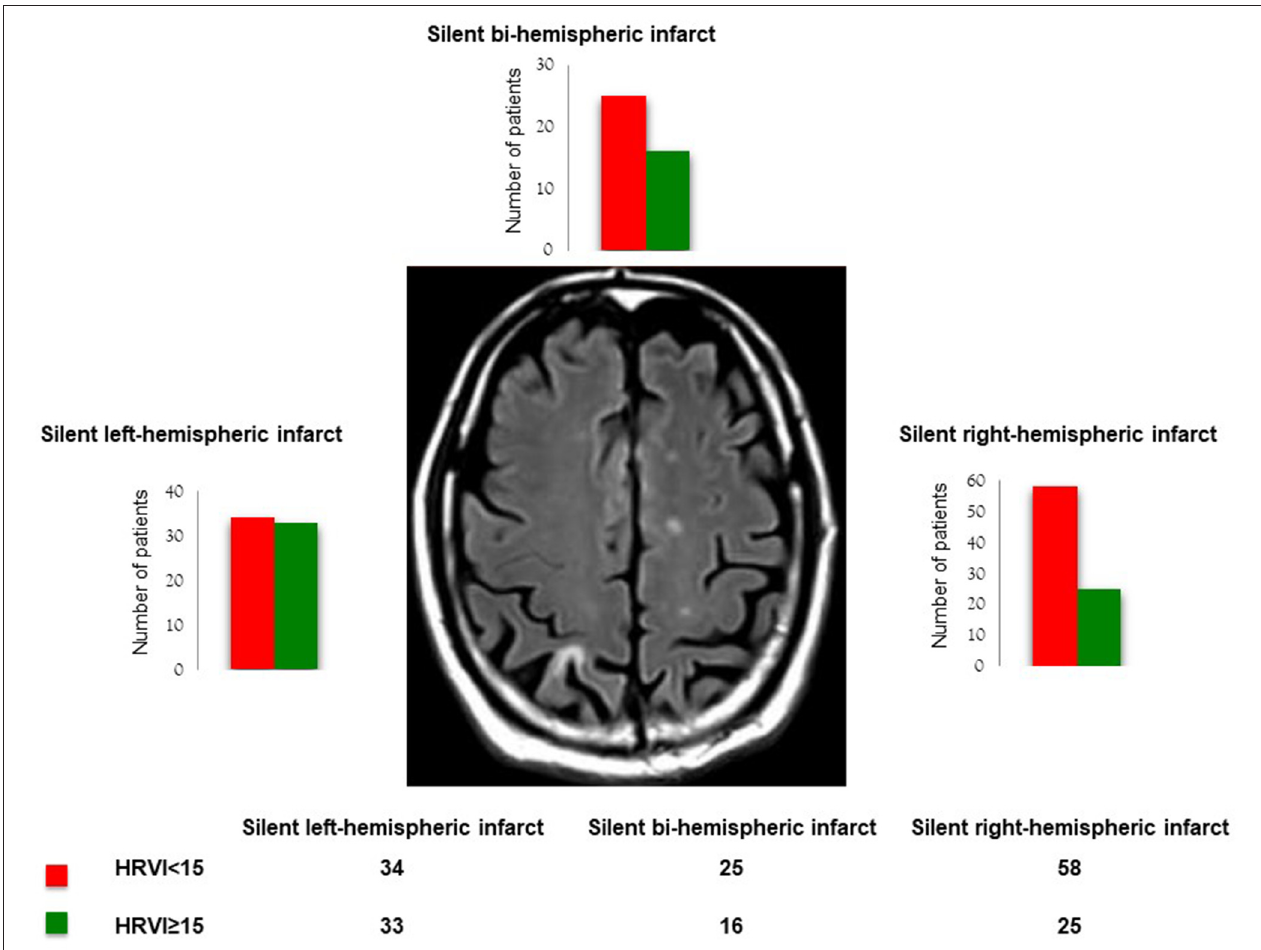
FIGURE 3 | Impairment of heart rate variability triangular index (HRVI) according silent brain infarct